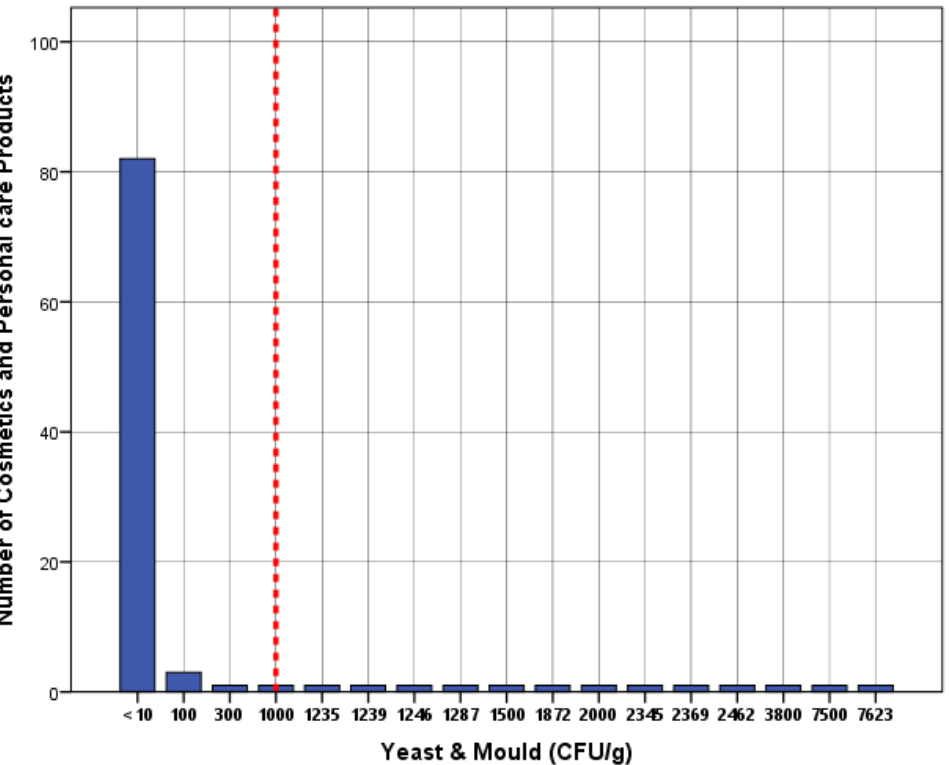
Figure 2. Histogram of the estimated yeast and mold (CFU/g) for cosmetics and personal care products ( n = 100). The vertical dashed line shows the microbiological maximum limits according to BS EN ISO 21150:2015.